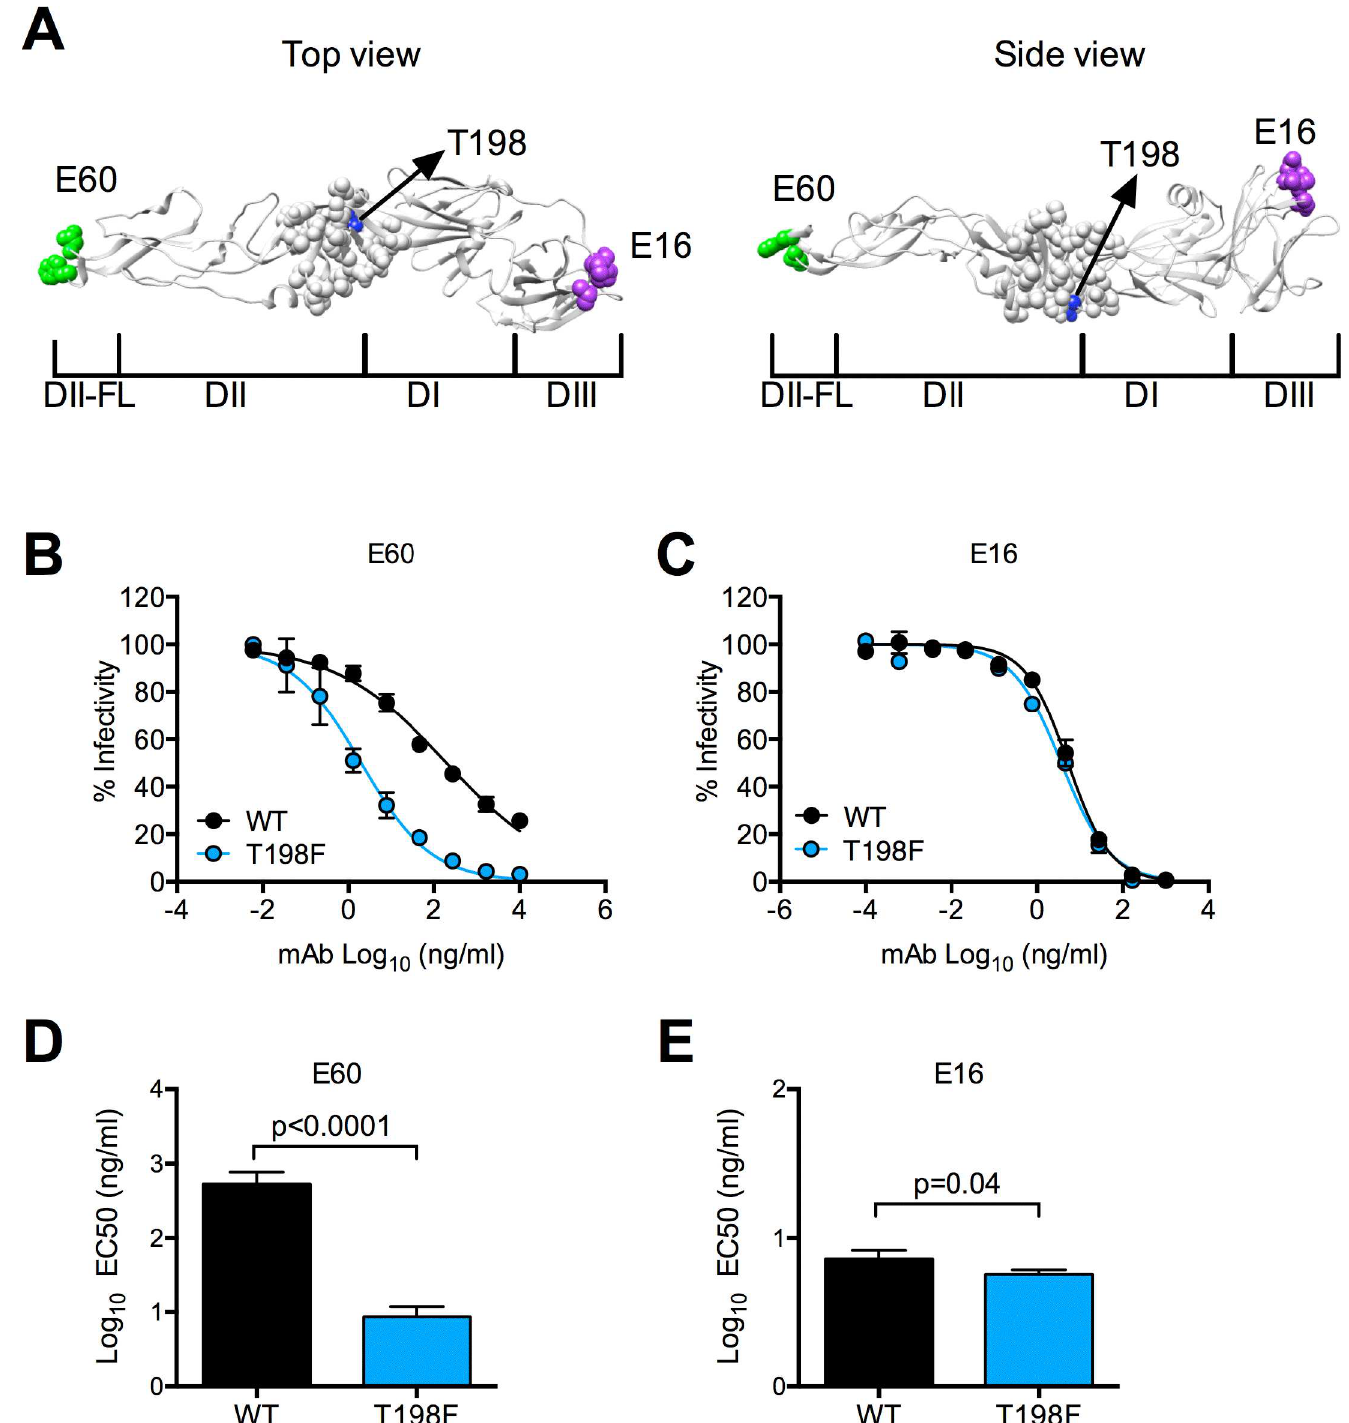
Fig 1. Neutralization sensitivity of WNV E T198F RVPs to mAbs. (A) Top (left panel)and side (right panel) views of the crystal structure of the WNV E protein monomer(PDB 2HG0) are shown, with domainsI, II, and III (DI, DII, and DIII), and the fusion loop of DII (DII-FL) indicatedbelowthe structure. The side view was obtained by rotating the structure in the left panel 90 degreestowards the page. On the structure, amino acid residues important for recognition by mAb E60 in the DII-FL [58] and by mAb E16 [59] in DIII are indicatedby the green and purplespheres, respectively.Gray spheresindicate residueswithin DI-DII hinge that were mutated for epitopemappingstudies. The blue spheresand black arrow indicate the locationof threonineat E protein residue 198 describedin this study (B) Representative dose-response neutralization curves for WT and T198F WNV RVPs tested concurrently